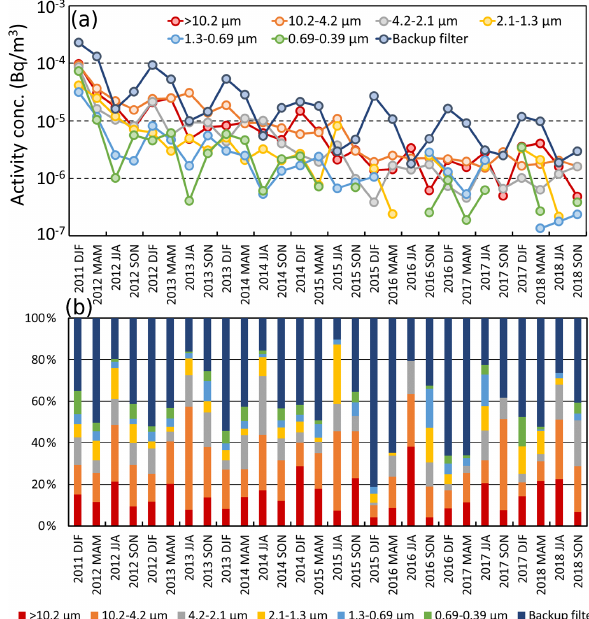
Figure 4. (a) Time series of seasonal mean size-resolved airborne surface concentrations of 137 Cs and (b) their relative